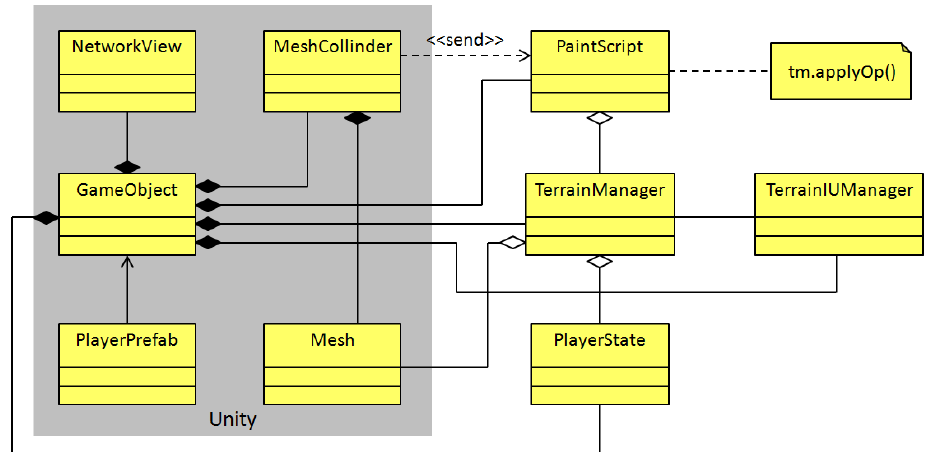
Figure 9. Class diagram of the collaborator creation and terrain mesh